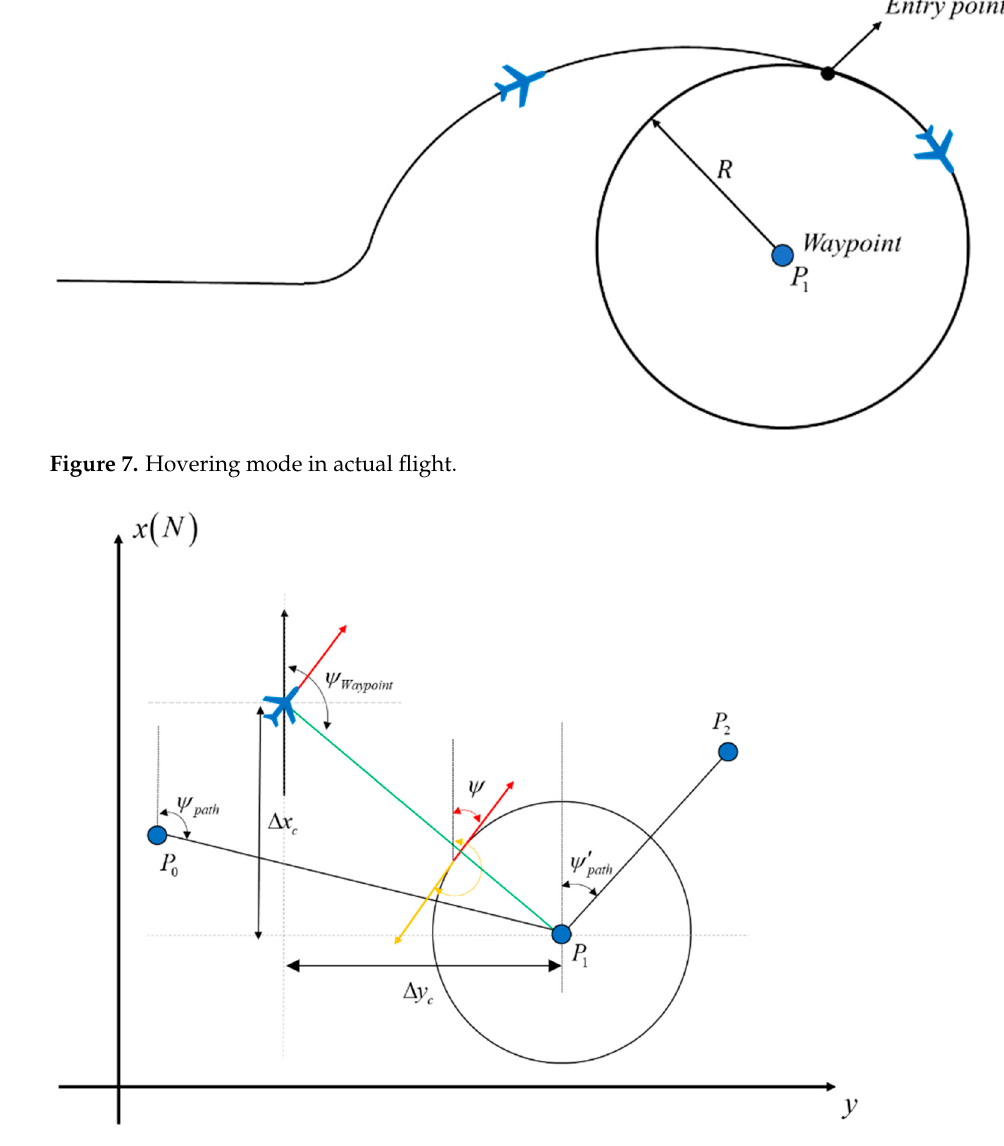
O X Y . The region between points A and B is shown in Figure 9. Points B and A f f